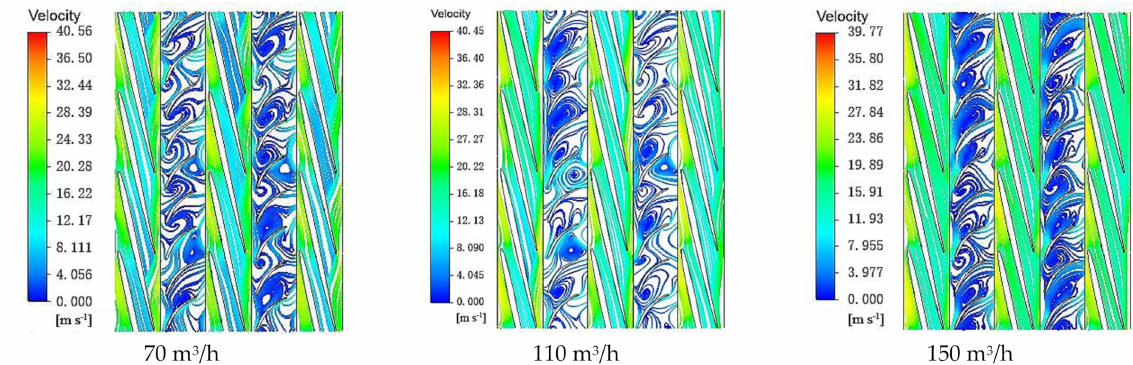
Figure 21. Axial streamline distribution at 0.2 span of the compressor stage.